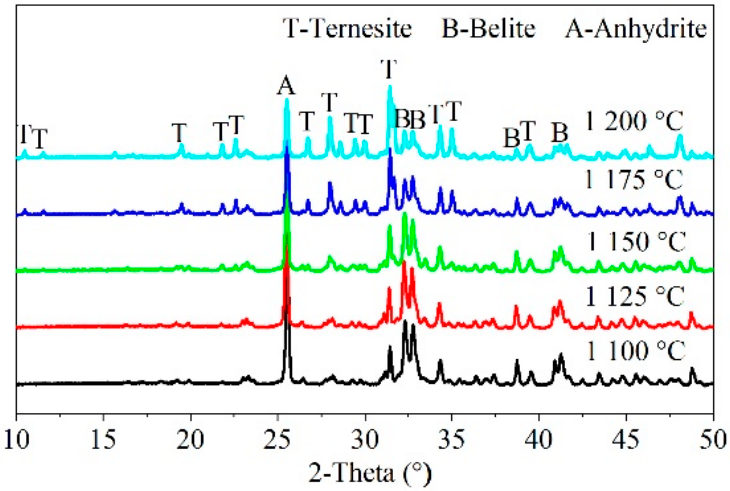
Figure 5. XRD patterns of samples at different temperatures (°C) without holding time.